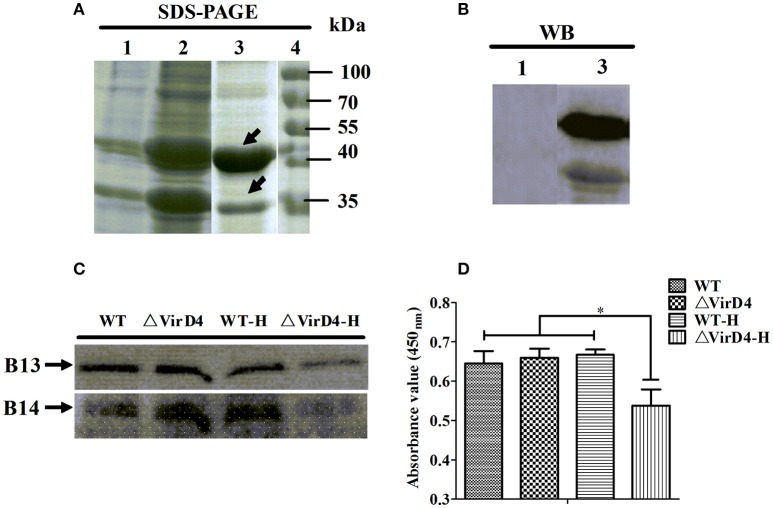
Verification of more secretion of PrsA protein in wide-type strain as compared with its ΔVirD4 mutant after hydrogen peroxide treatment. (A) Prokaryotic expression and purification of PrsA protein by SDS-PAGE. Lane 1, E. coli cell lysate from culture without IPTG induction; Lane 2, E. coli cell lysate from IPTG-induced culture; Lane 3, purified PrsA proteins, Lane 4, molecular weight markers. (B) Western blotting of Lane 1 and Lane 3 of (A) using anti-His monoclonal antibody. (C,D) Secretion of PrsA protein in the culture supernatant samples of the wild-type S. suis type 2 strain and its ΔVirD4 mutant after hydrogen peroxide treatment by Western blot (C) and ELISA (D) using the rabbit anti-PrsA polyclonal antibodies for probing. WT-H or ΔVirD4-H means the wild-type or ΔVirD4 strain were treated with 10 mM H2O2. *Indicated significant at P < 0.05. The arrows in (A) indicate two possible isoforms of PrsA [same for (C)].